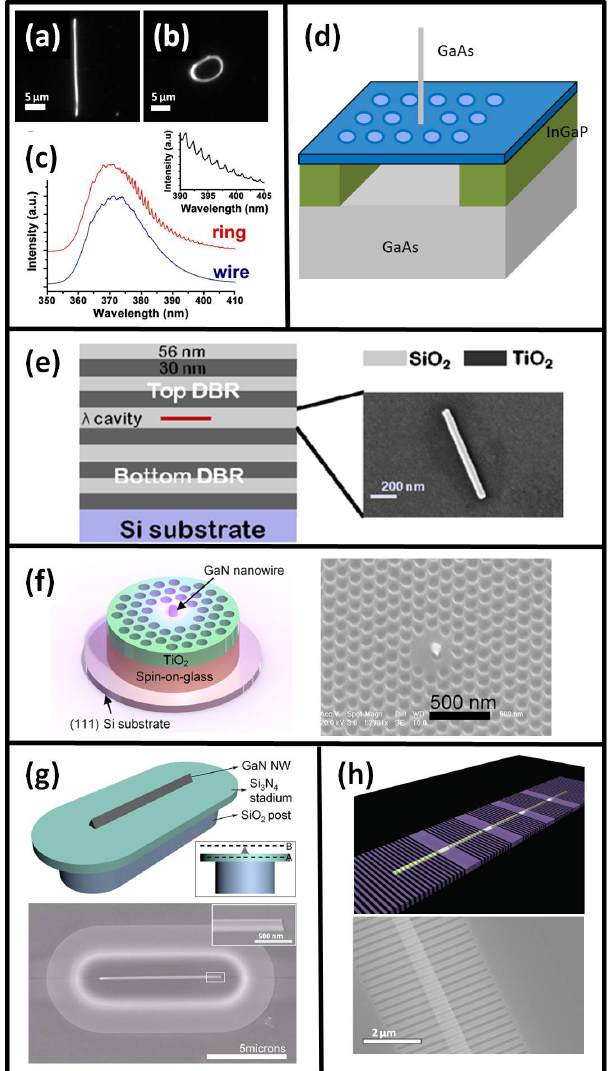
Figure 4: Various photonic structures. SEM images of (a) a nanowire and (b) a ring resonator, with (c) their emission spectra (adapted with permission [81]). (d) Vertical nanowire on a PhC cavity (ex- tracted with permission [52]). (e) Left: Schematic of a nanowire in a DBR microcavity; right: SEM image of the nanowire (adapted with permission [19]). (f) Schematic (left) and SEM image (right) of a GaN nanowire standing on a PhC (adapted with permission [36]). (g) Schematic (top) and SEM image (bottom) of a nanowire placed on a microstadium structure; inset: focus at the tip of the nanowire (adapted with permission [79]). (h) Schematic (top) and SEM image (bottom) of a nanowire lying on a microresonator structure (adapted with permission